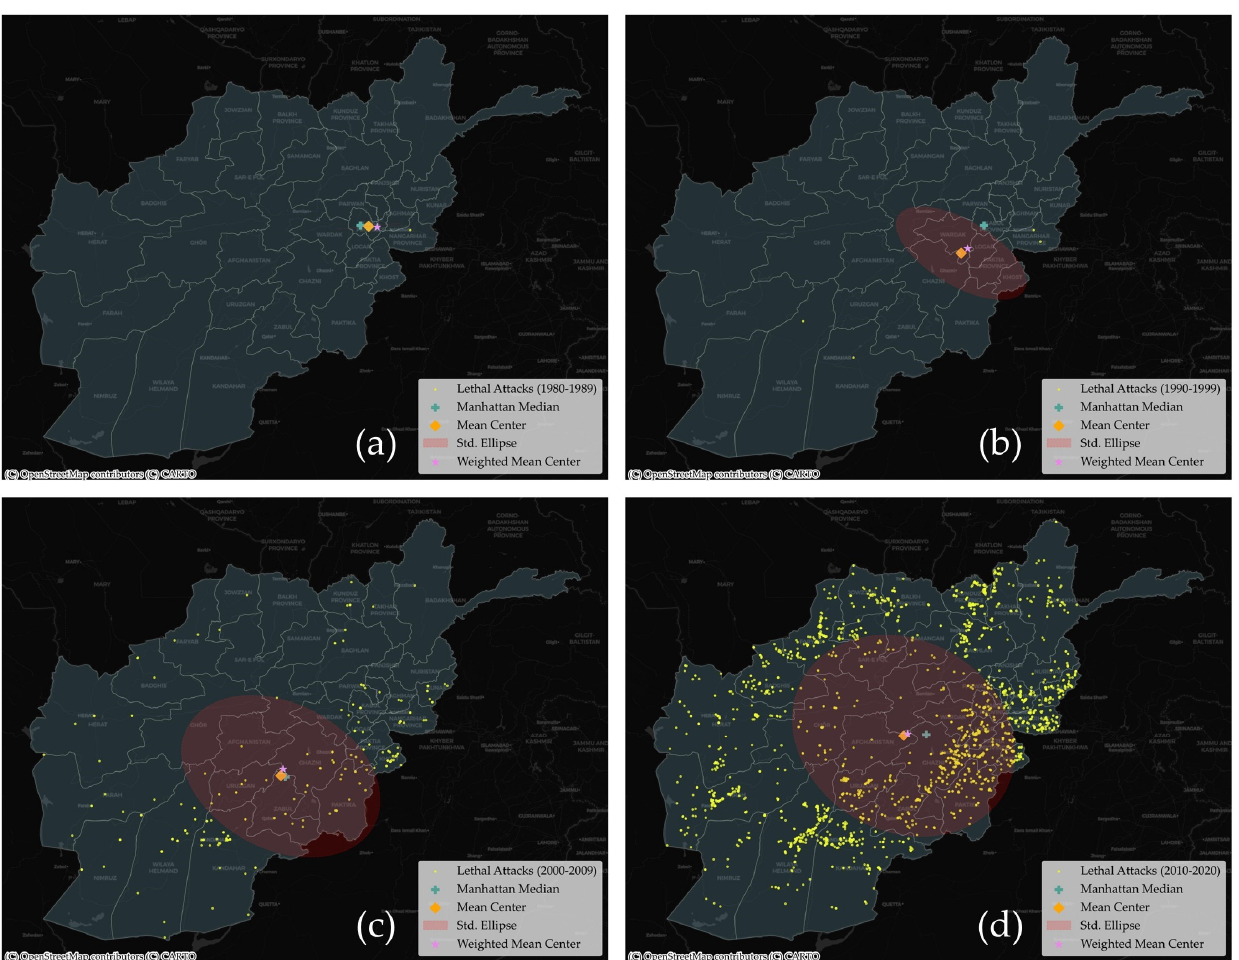
Figure 5. Spatiotemporal evolution of lethal terrorist activities. ( a ) Lethal attacks in the decade 1980–1989. ( b ) Lethal attacks in the decade 1990–1999. ( c ) Lethal attacks in the decade 2000–2009. ( d ) Lethal attacks in the decade 2010–2020.